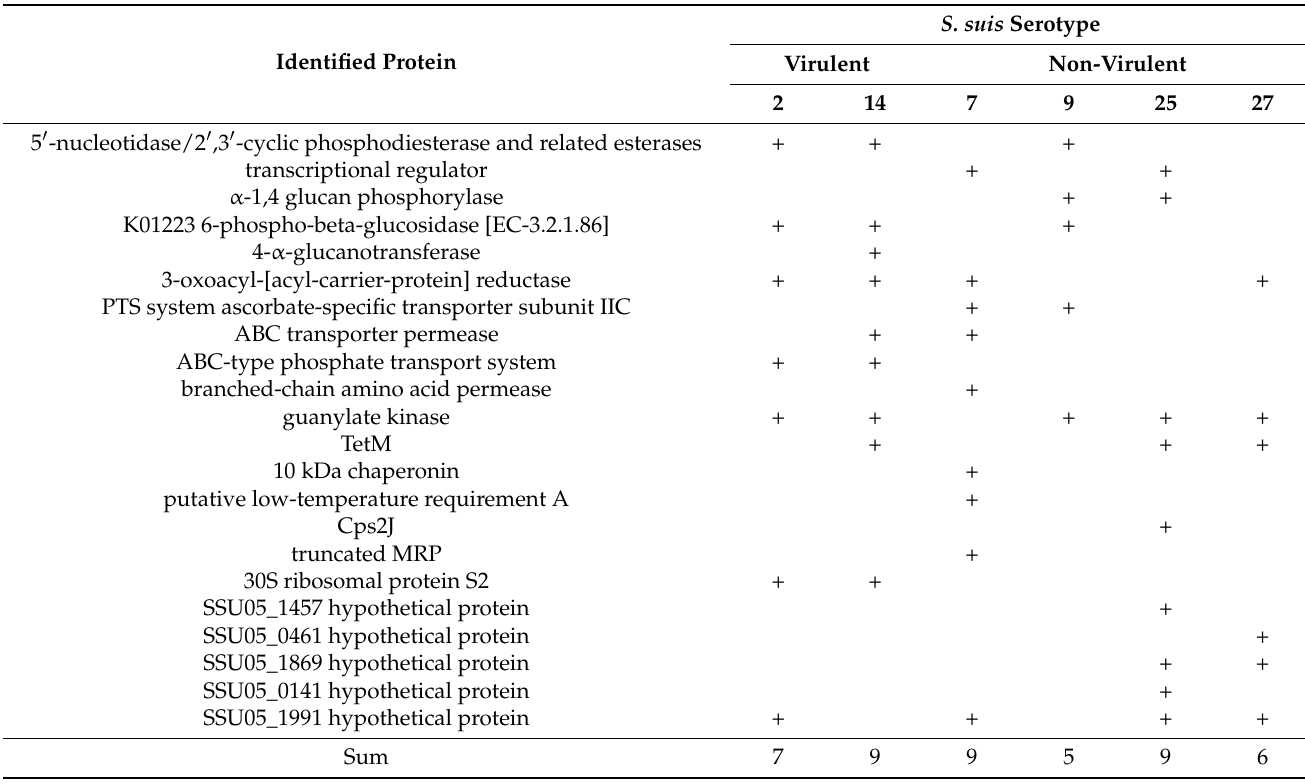
Table 2. Distribution of 22 identified peptides derived from S. suis proteins of virulent vs. non-virulent S. suis to human cultured under host simulated environment.